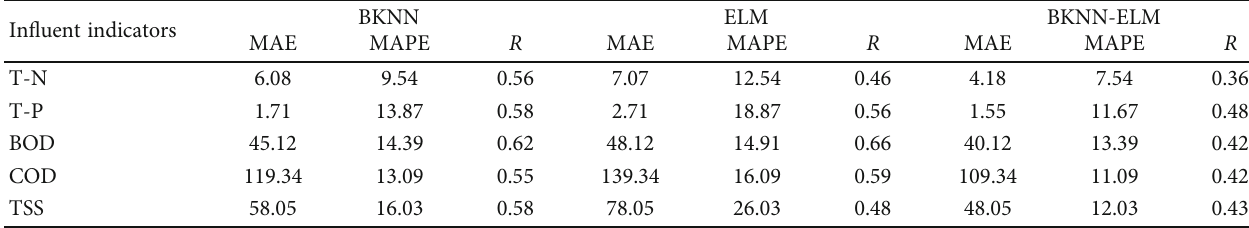
Table 4: Parametric values of MAE, MAPE, and R using fusion of BKNN-ELM. In fl uent indicators